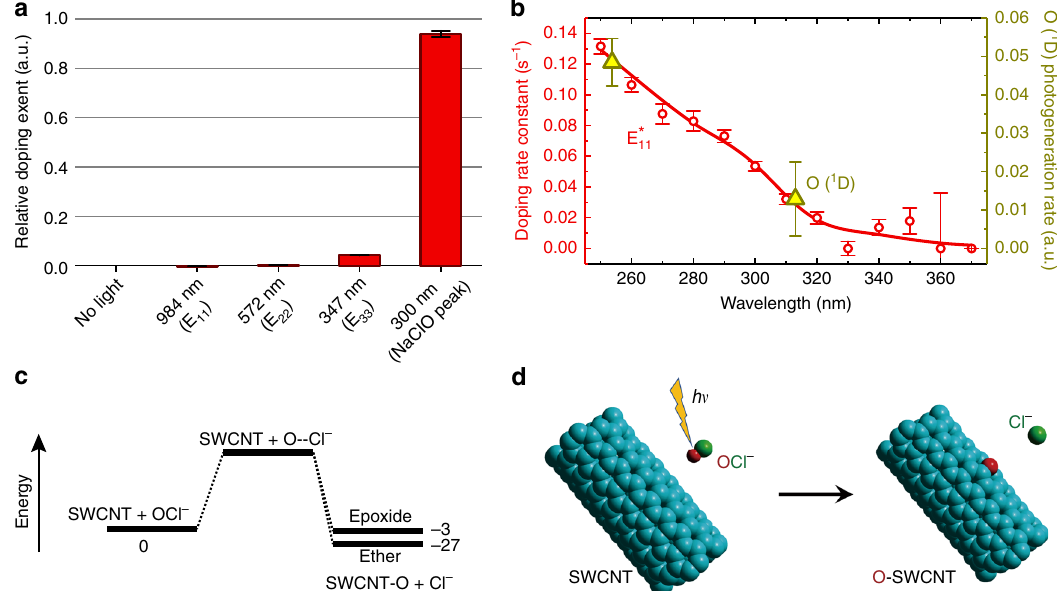
Fig. 2 Mechanism of oxygen doping using NaClO. a The relative doping extents in samples irradiated at SWCNT resonant absorption peaks and at the 300 nm NaClO absorption peak. Relative doping extent is de fi ned as E (cid:1) spectral measurement noise. b Action spectrum of the doping rate constant (circles), and relative photogeneration rates of O ( 1 D) (triangles). Error bars indicate s.d. estimated from literature uncertainties and spectral measurement noise. c Diagram showing computed energies for reactants, products, and proposed transition state for the doping reaction in vacuum (units: kcal mol − 1 ). Note that the ether adduct is more stable than the epoxide. d Illustration